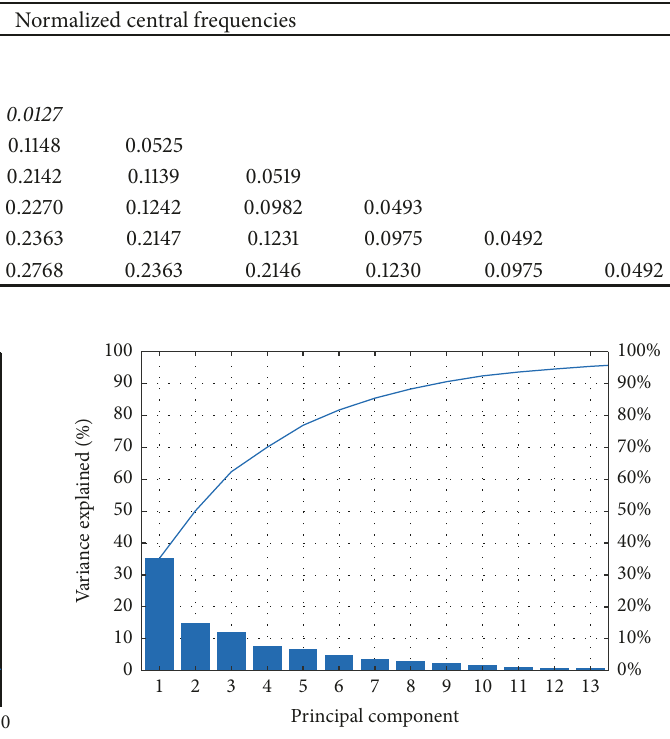
Figure 6: Principal component distribution of feature